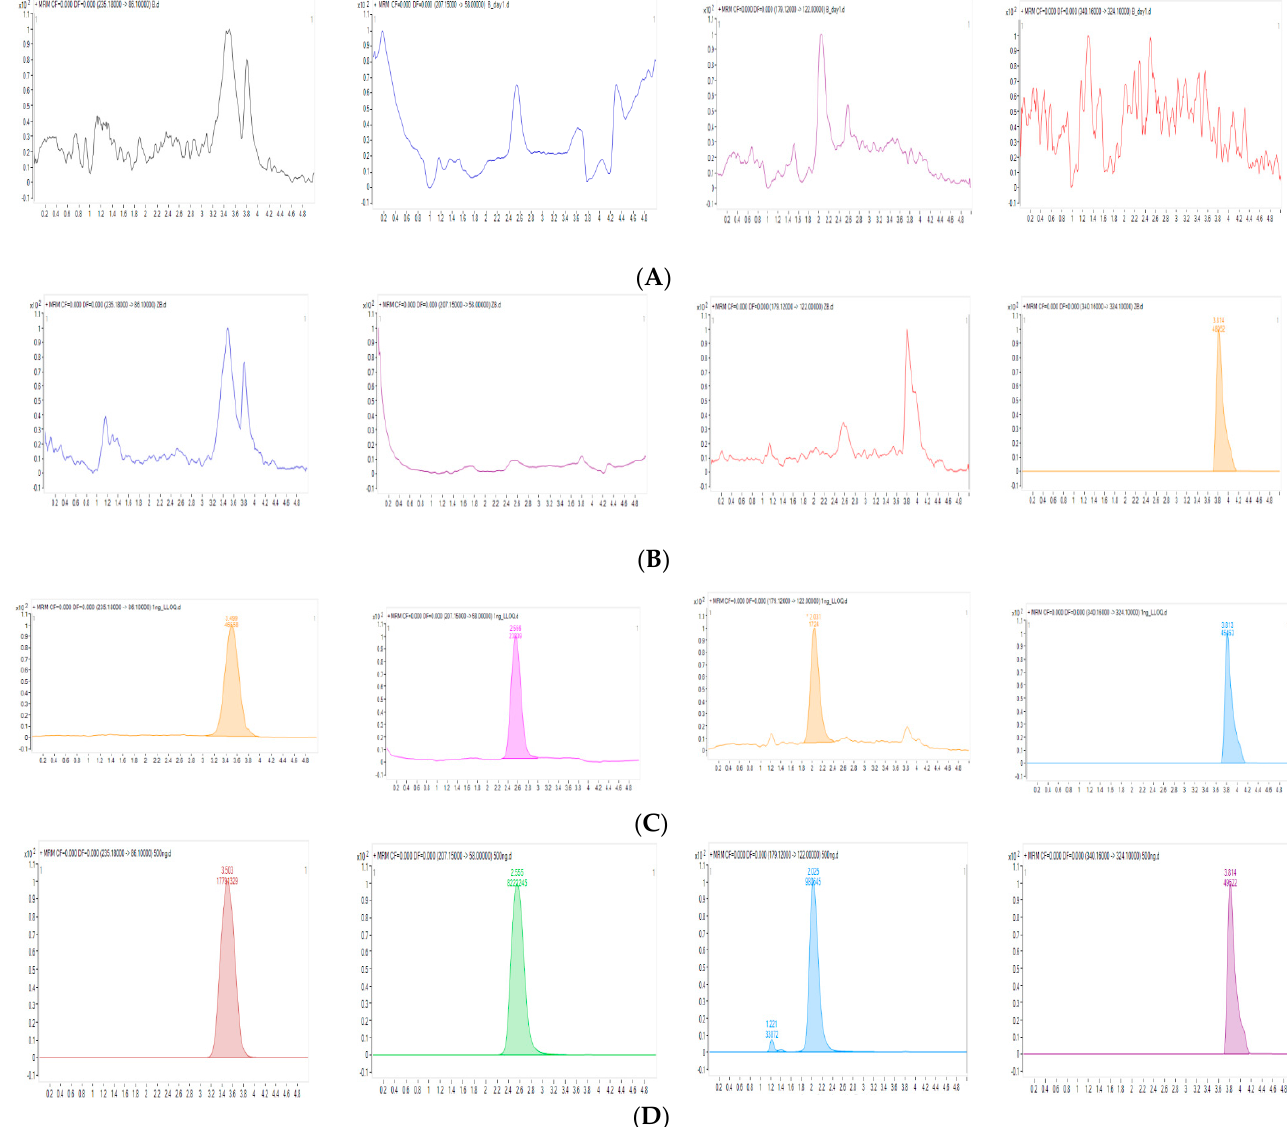
Figure 2. Representative chromatograms of Blank ( A ), Zero-blank ( B ), Lower limit of quantitation (LLOQ) ( C ), and Upper limit of quantitation (ULOQ) ( D ) calibration standard samples. The x-axis and y-axis represent the retention time (min) and relative response, respectively.